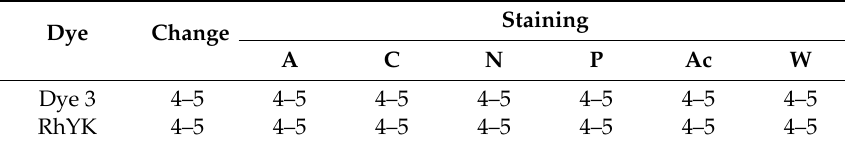
Table 1. Wash fastness of fabricated textile sensors.